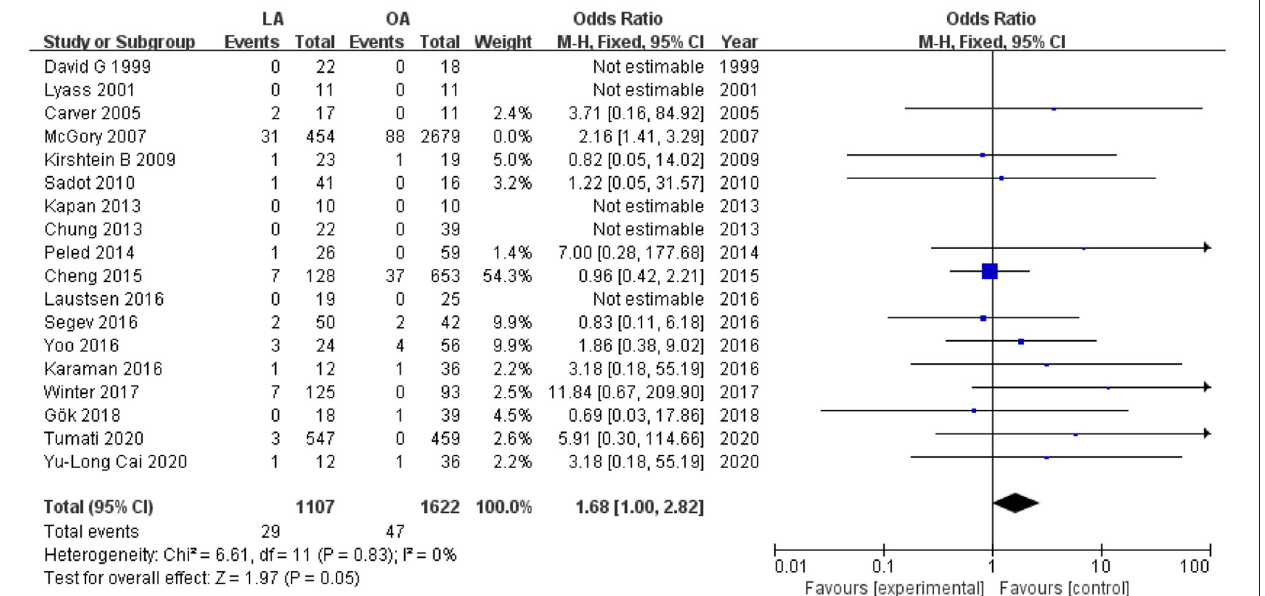
Frontiers in Surgery |